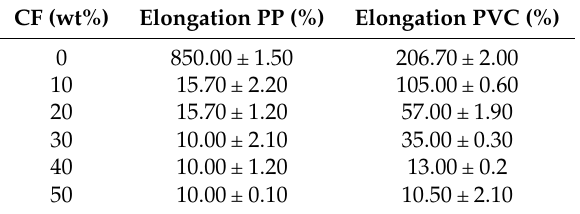
Table 6. Average elongation at break for PP and PVC set with different filler content,